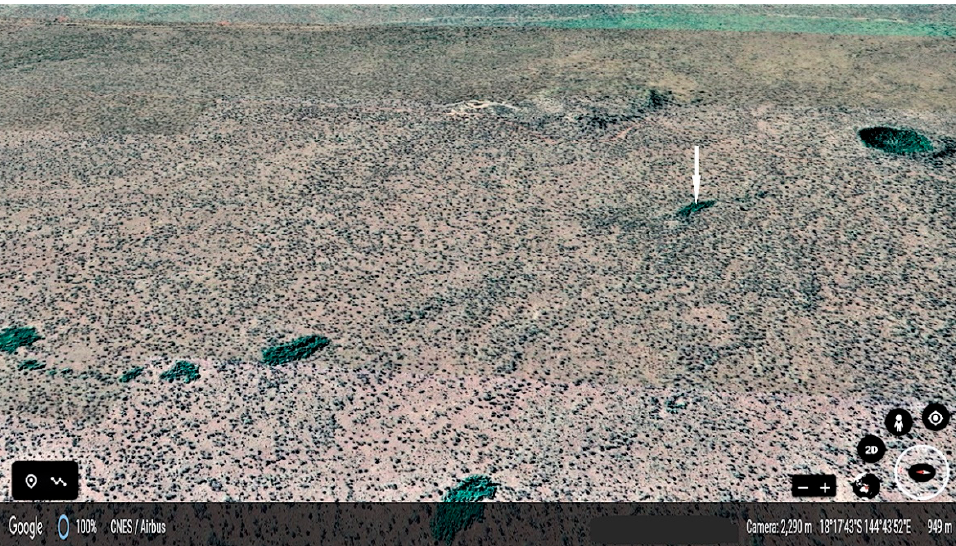
Figure 3. Oblique view looking East showing Undara Crater in the upper right corner and the entrance to Taylor Cave about one kilometre downslope (arrowed). Contrasting with the surrounding dry savanna woodland, the conspicuous ribbon of dark-green ‘islands’ are remnant vine-thicket vegetation growing in depressions and collapsed caves and revealing the course of the lava tube system. Picture from Google Earth. Scale not shown in this oblique view since apparent distances will vary depending on position.